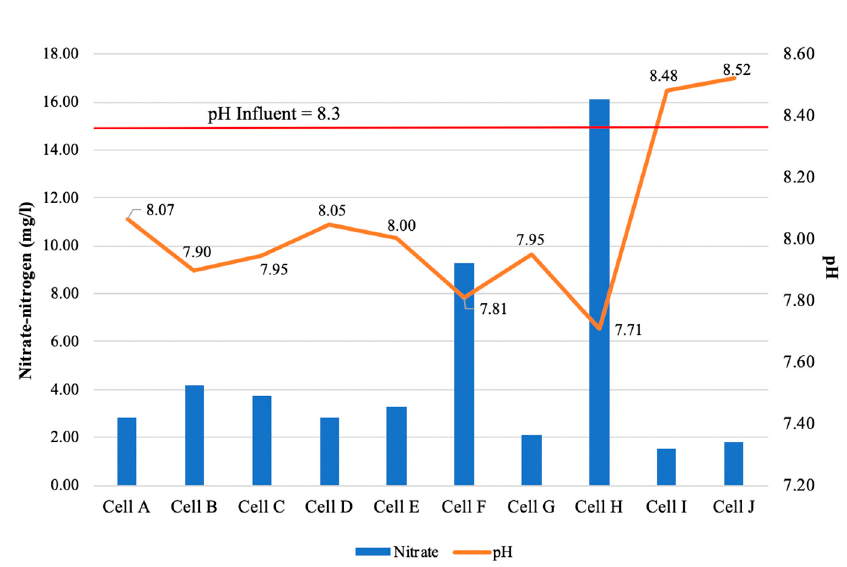
Figure 15. Relationship between pH and nitrate-nitrogen concentration.